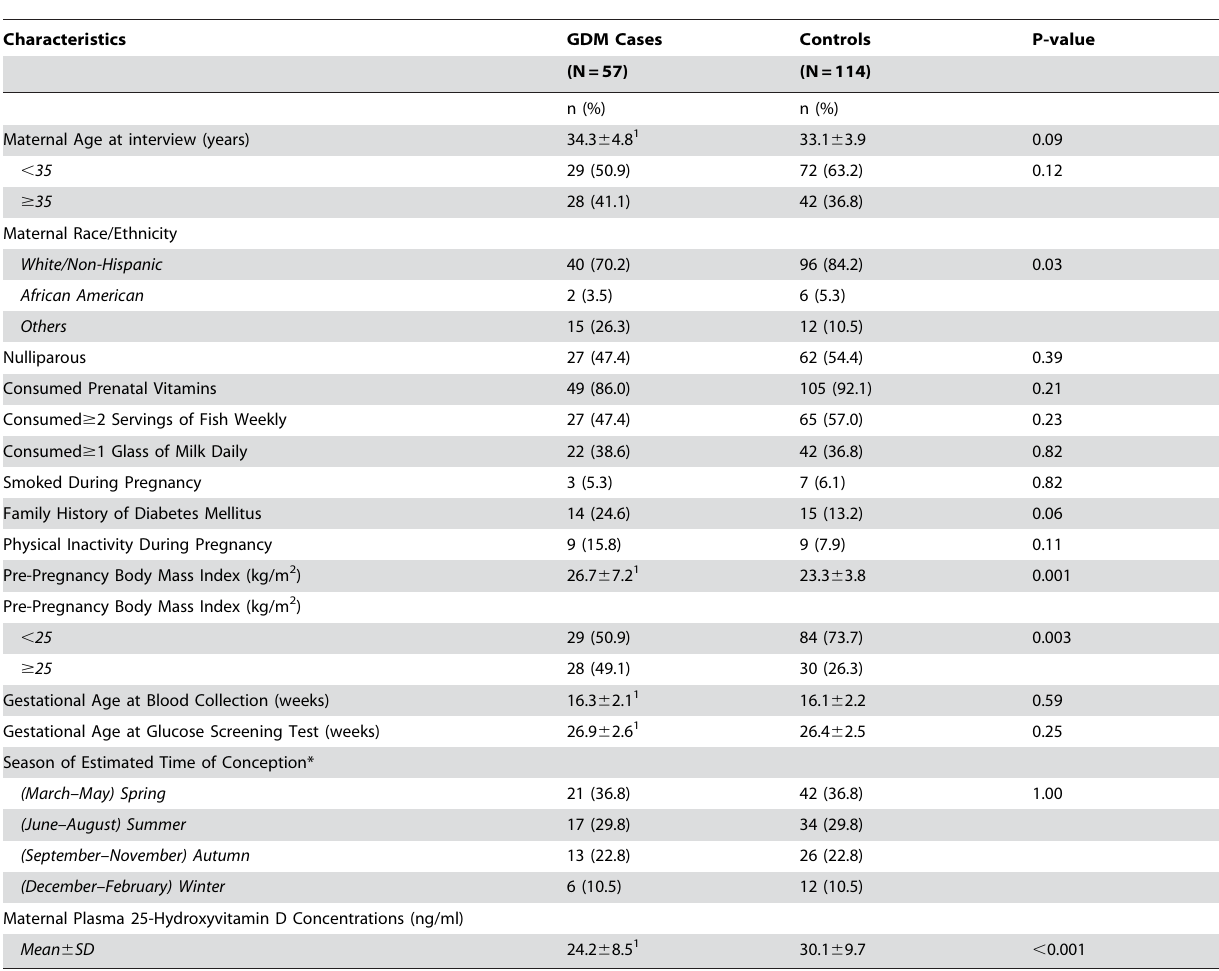
Table 1. Characteristics of study participants according to gestational diabetes (GDM) case-control status.